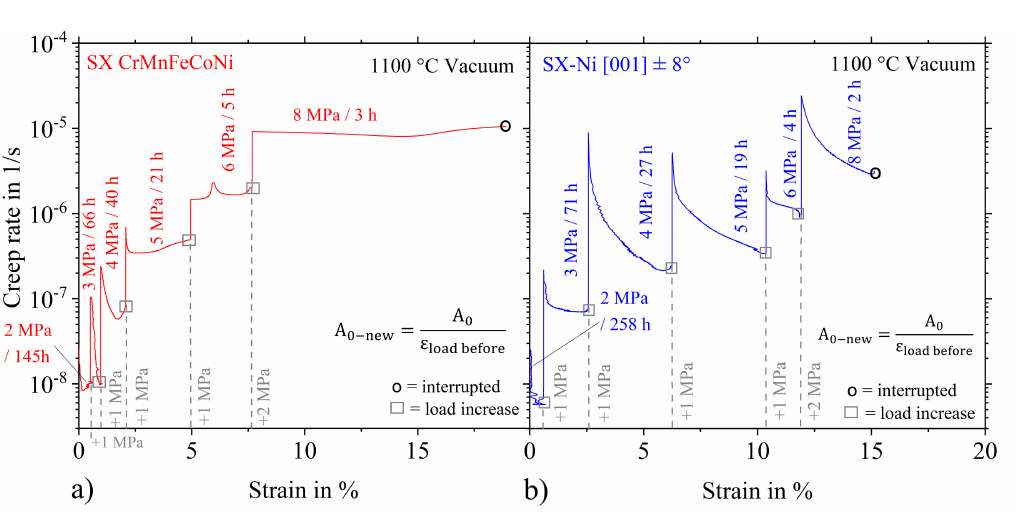
Figure 5. Creep rate over strain diagrams for the creep tests of the single crystalline ( a ) CrMnFeCoNi